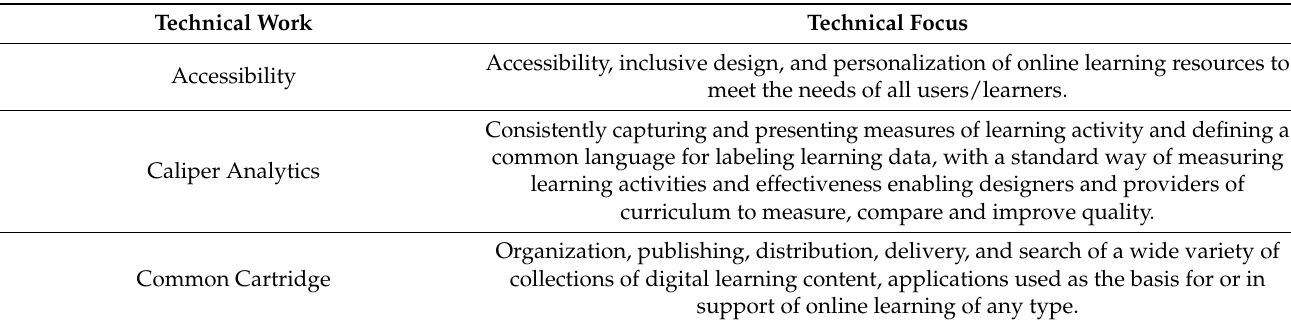
Table 1. 1EdTech Technical work and technical focus